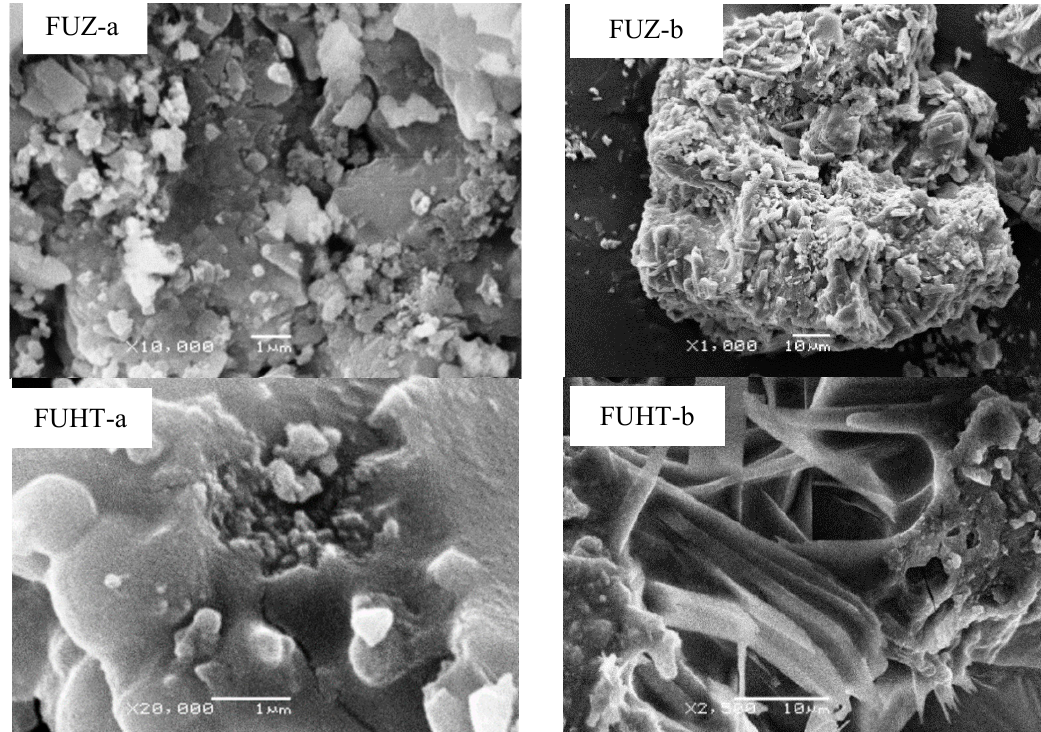
Figure 3. SEM micrographs showing variable morphologies of RFA-, HTZ-, FUZ-, and FUHT-based Na-zeolites derived from RFA under different magnification scales (a = 1 μ m and b = 10 μ m).